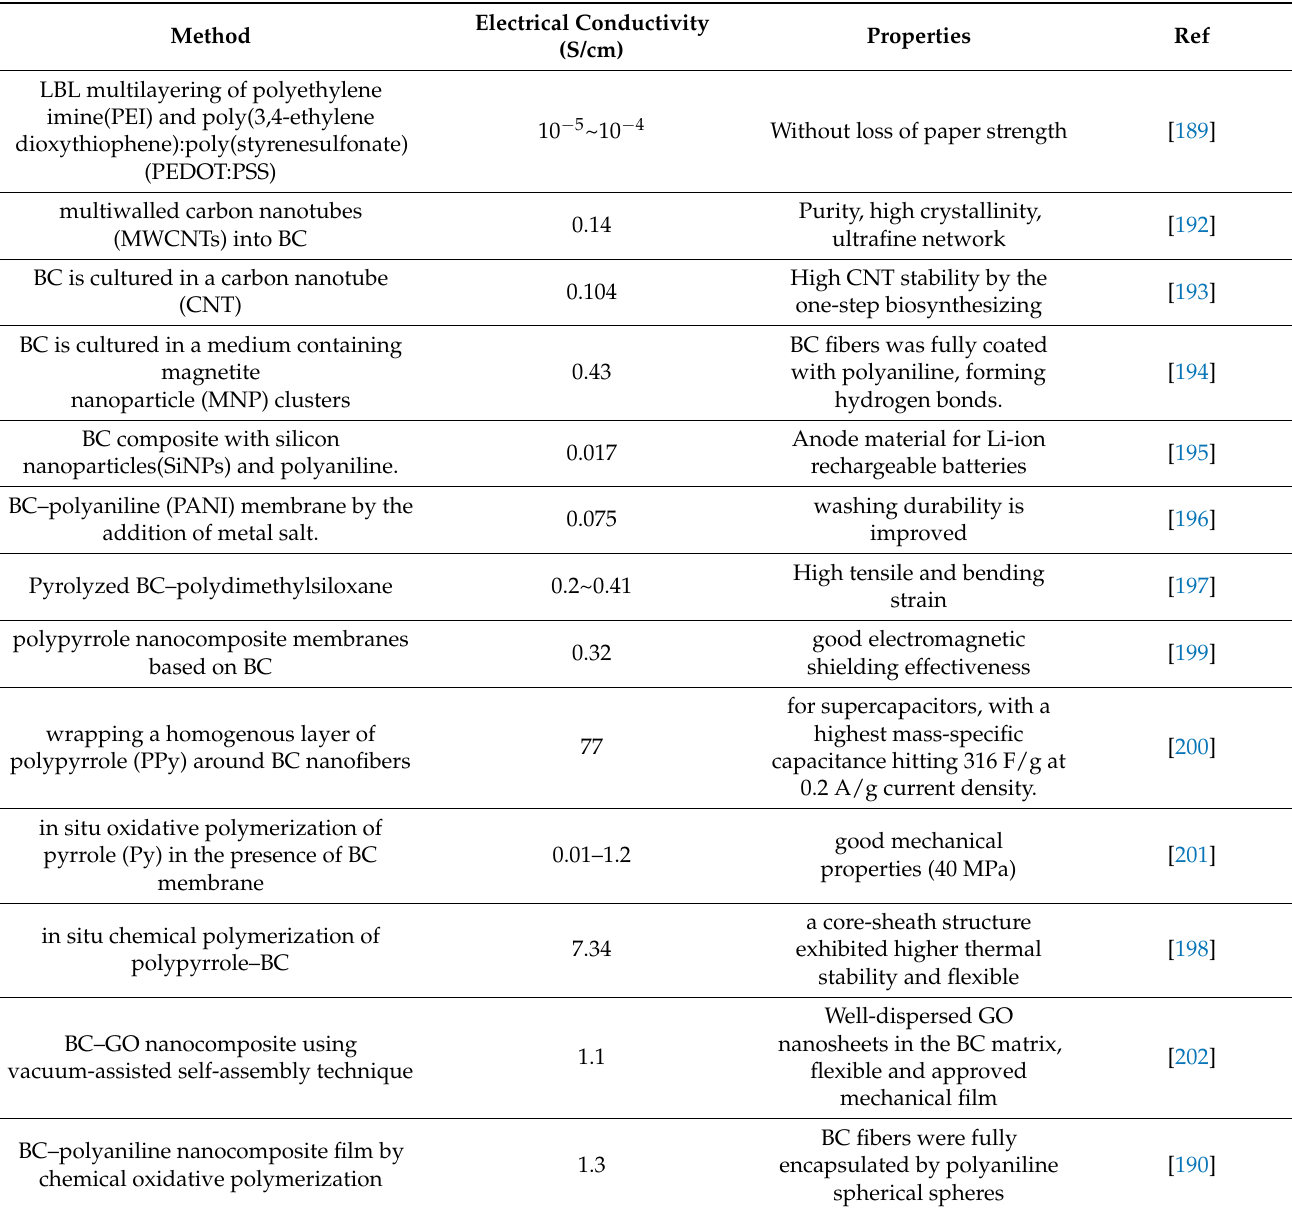
Table 2. Electrical properties of BC